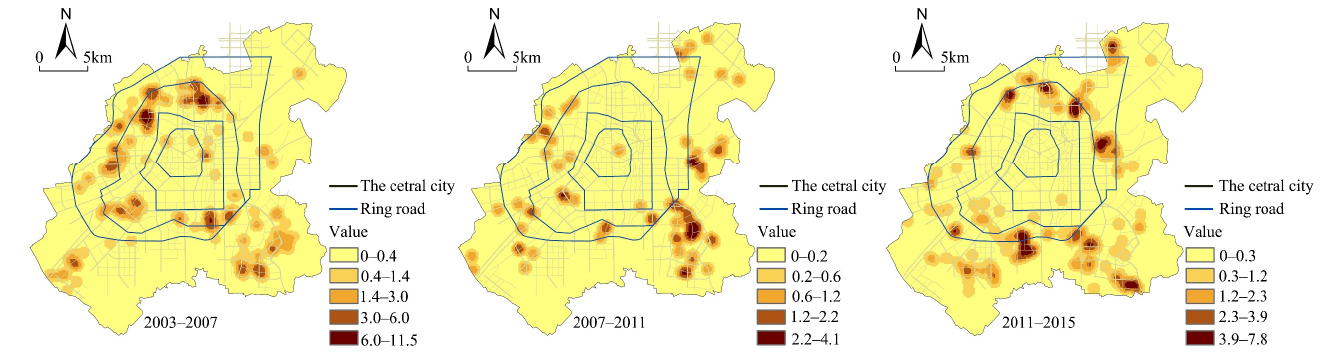
Figure 6. Kernel density map of residential land expansion in different periods.